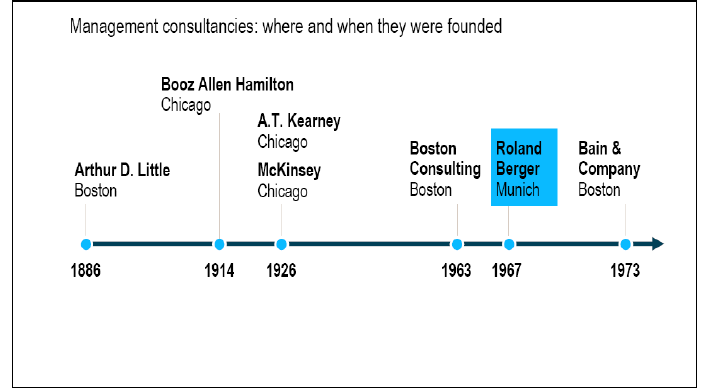
Figure 1 : Management Consultancies: Where and When They Were